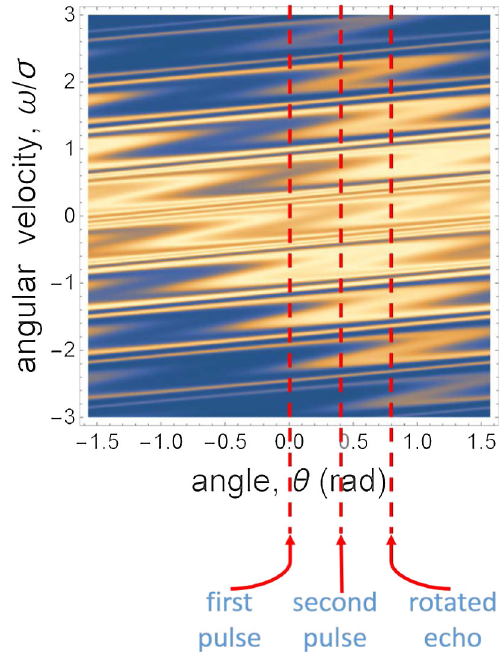
FIG. 3. Formation of the rotated echo. The polarization angles of the first and the second pulses, as well as the direction of the rotated echo are indicated by the three red dashed lines. The first pulse is applied at t ¼ 0 , θ ¼ 0 , with Ω 1 = σ ¼ 1 . The second pulse is applied at t ¼ T (such that σ T ¼ 5 ), at crossing angle β ¼ 0 . 4 with respect to the first pulse, and with Ω 2 = Ω 1 ¼ 1 = 3 . The rotated full echo is formed at τ ≈ T (namely, when στ ¼ 4 . 56 ), and at angle θ ¼ 0 . 8 ð 2 β Þ